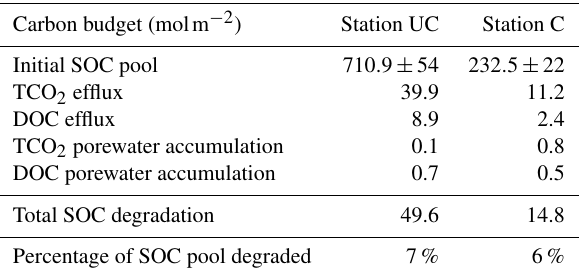
Table 2. Carbon budget table showing mean soil organic carbon (SOC) ± SEP ( n = 18) in uncultivated (UC) and cultivated (C) soil. Total time integrated efflux and accumulation of total carbon diox- ide (TCO 2 ) and dissolved organic carbon (DOC) in porewater are also